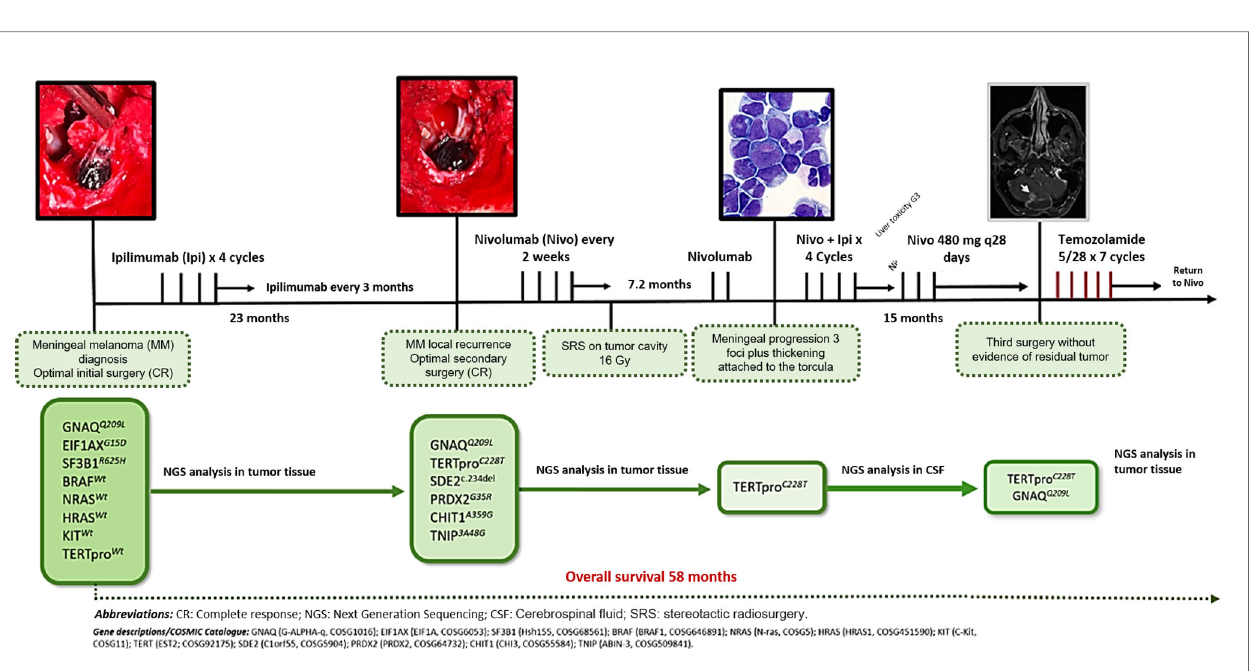
FIGURE 6 | Graphic evolution of the clinical case and of the tumor genomics evaluated by NGS in tumor tissue and CSF.